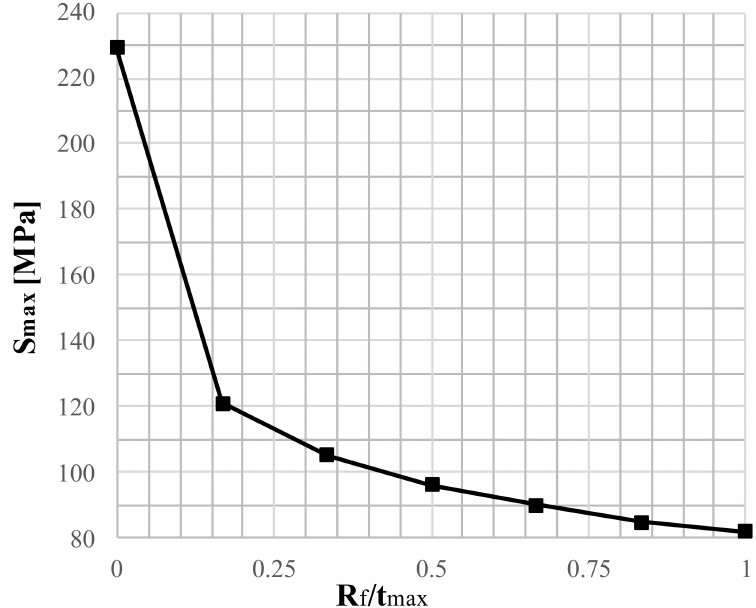
Figure 13. Stress level versus R f /t